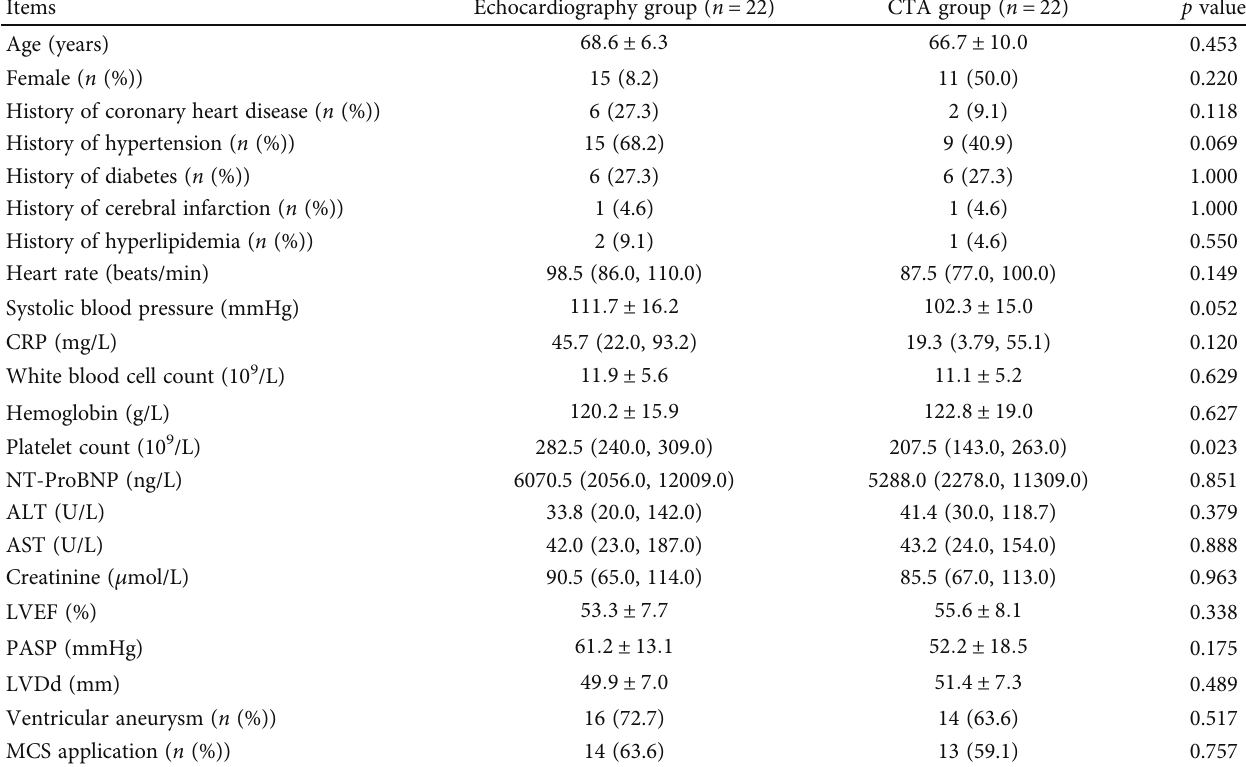
Table 1: Baseline comparison between the echocardiography group and CTA